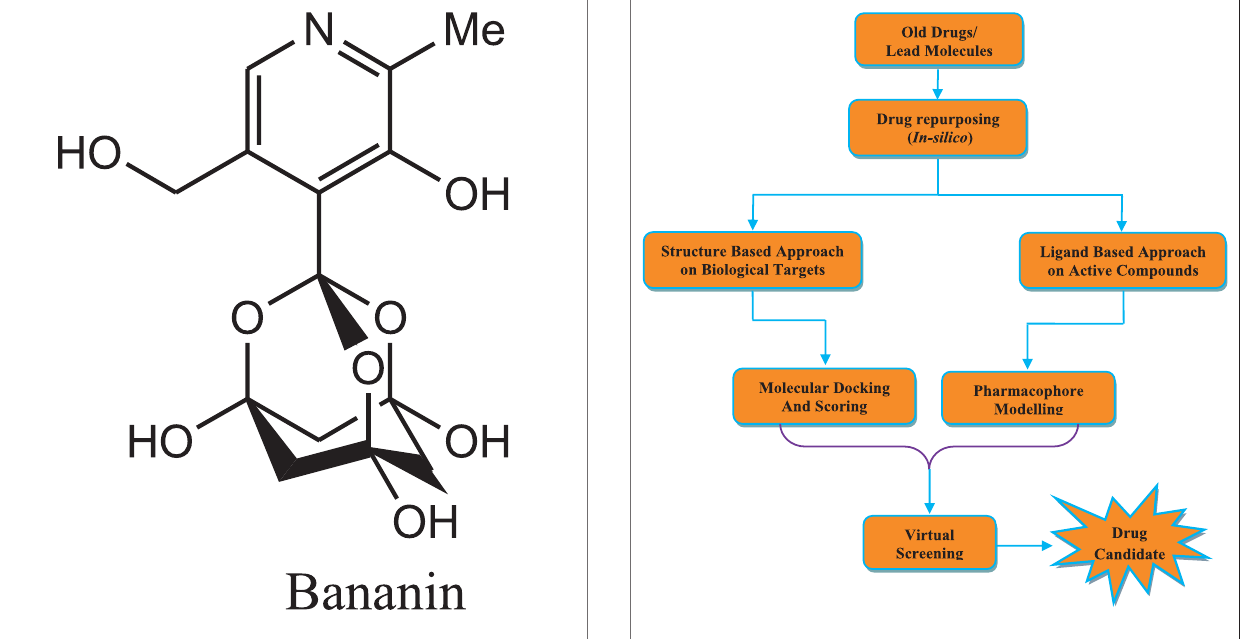
FIGURE 5 | Various steps involved in drug repurposing study. FIGURE 4 | Structure of SARS-CoV helicase